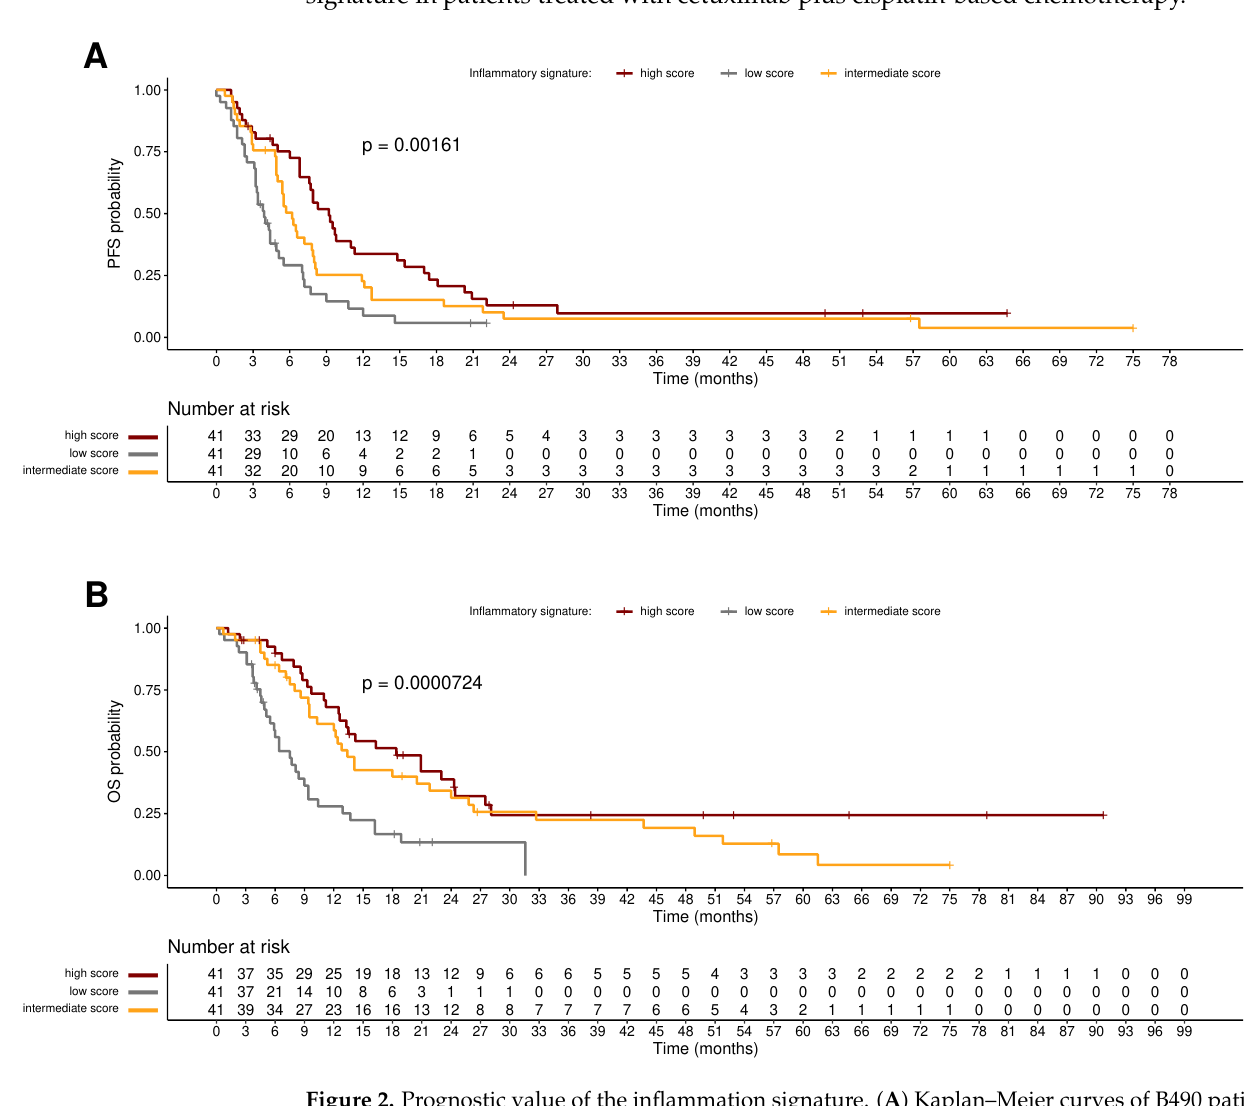
Figure 2. Prognostic value of the inflammation signature. ( A ) Kaplan–Meier curves of B490 patients’ PFS associated to the four-gene inflammatory signature. ( B ) Kaplan–Meier curves of B490 patients’ OS associated to the four-gene inflammatory signature. Curve separation was assessed by the log- rank test. Samples were stratified based on tertiles: high (red), intermediate (yellow) and low (gray) inflammatory score